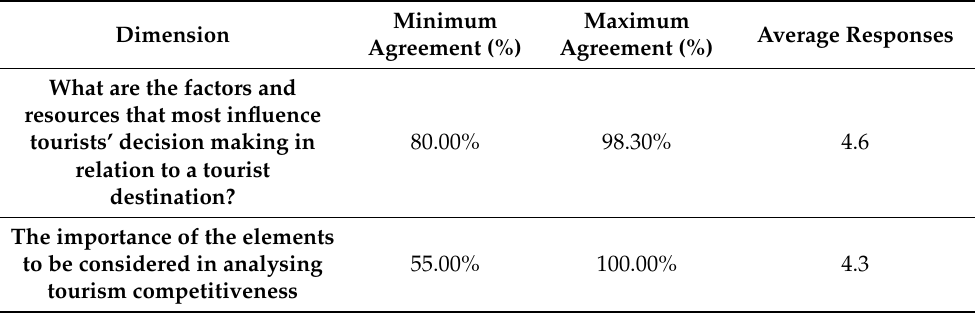
Table 13. Minimum and maximum agreement of the first domain of the interviews. Source: Elabo- rated by the